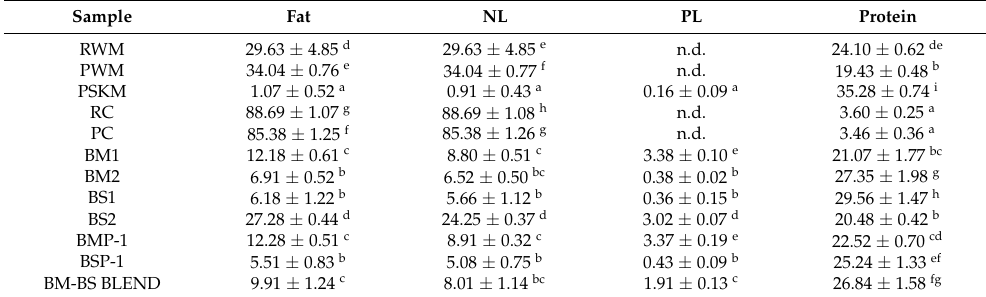
Table 1. Mean values of the fat, neutral lipid (NL), polar lipid (PL), and protein of the milk, cream, and by-product samples of the butter and butter oil manufacturing